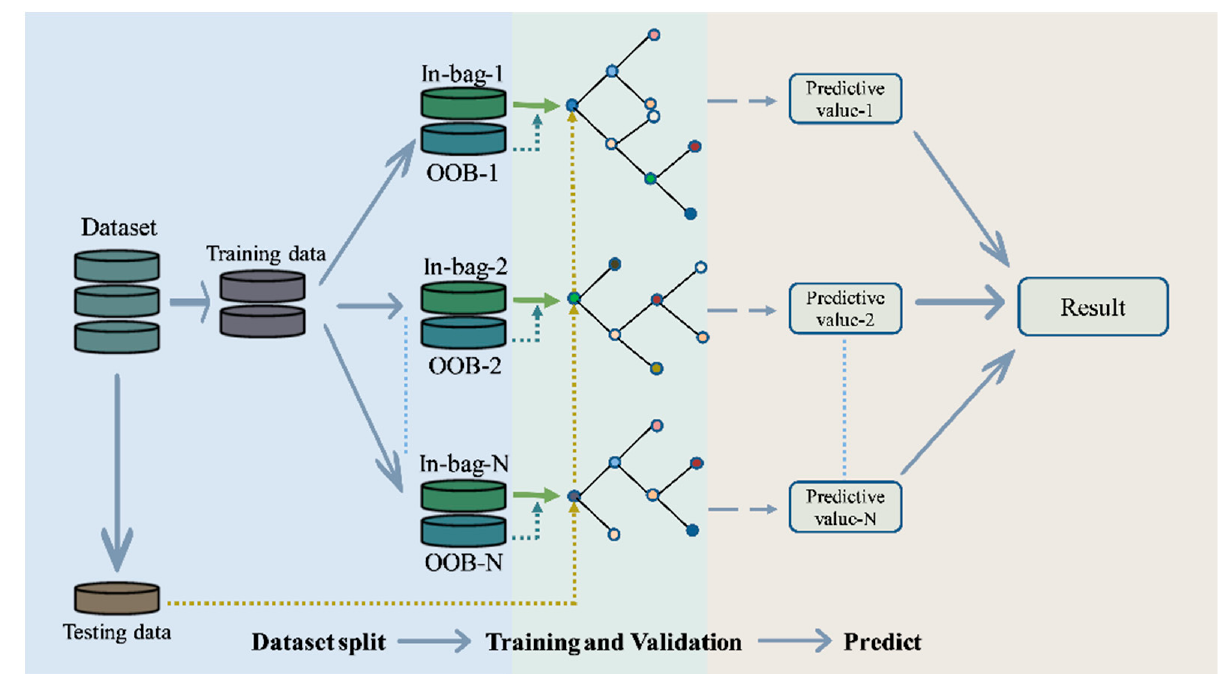
Figure 2. Theory of Random Forest Algorithm.